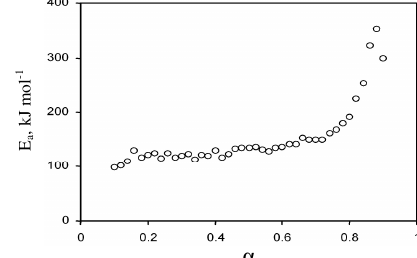
Figure 2. Variation of the E the first stage decomposition of